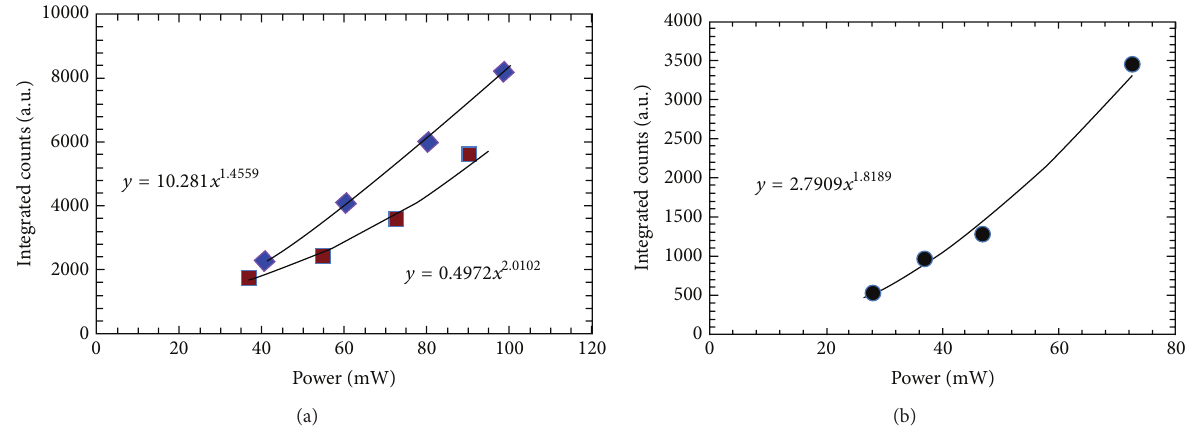
Figure 10: Power dependence of dye-induced upconversion of NaYF 4 :Yb 3+ , Ho 3+ with DY-831 dye under excitation of dye at 819 nm and 785 nm, blue diamonds and brown squares respectively (a); Power dependence of dye-induced upconversion of NaYF 4 :Er 3+ with DyL800 under excitation of dye at 785 nm